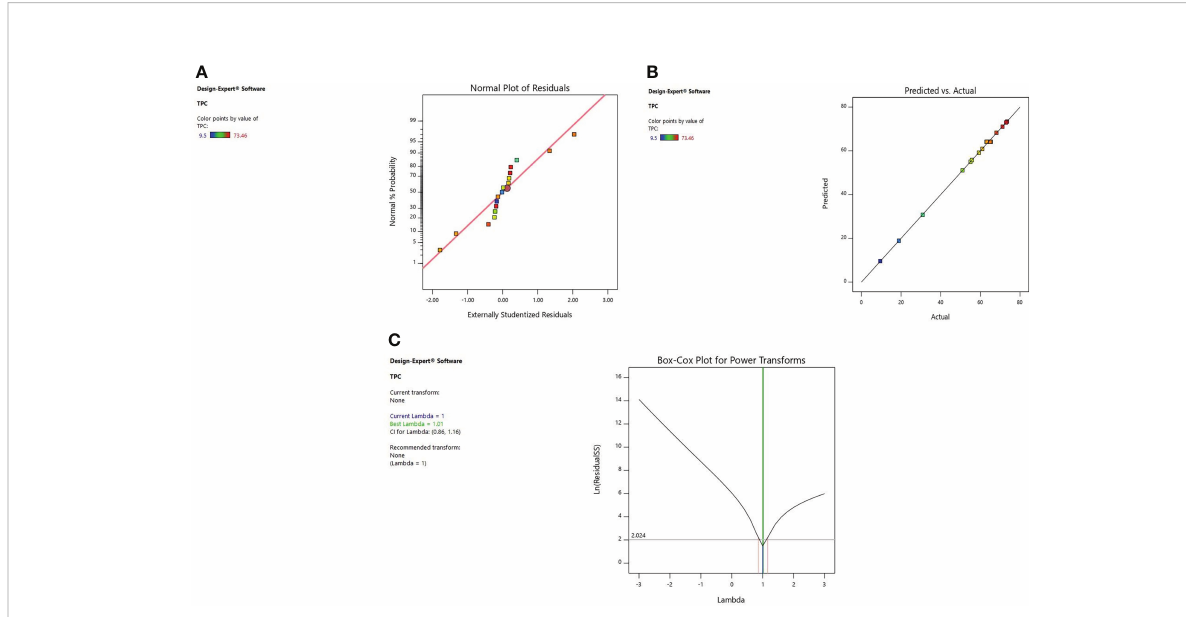
FIGURE 2 Diagnostic plot of TPC; (A) Normal % probability versus internal residual, (B) Actual versus predicted values, (C) Box-cox